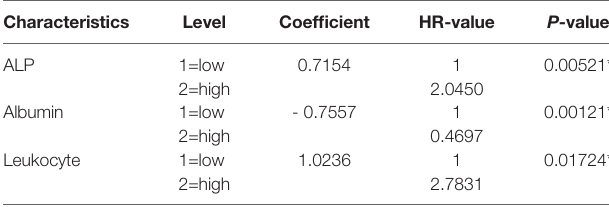
TABLE 3 | Factors included in the Risk-H